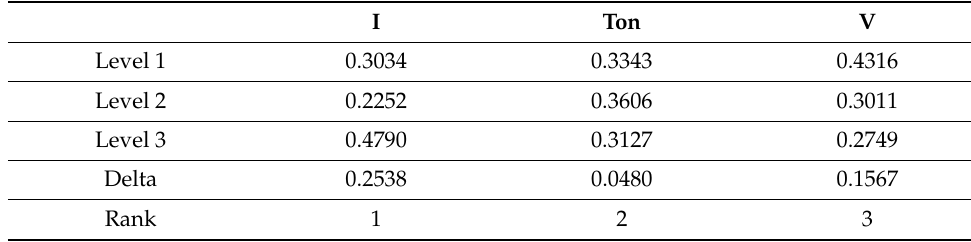
Table 8. Response table for sample C.